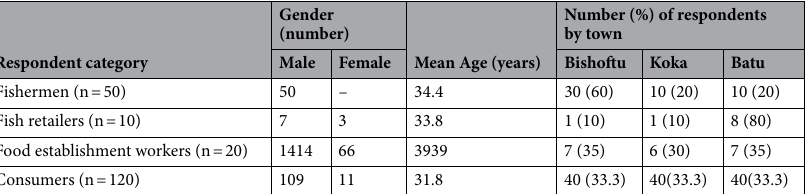
Table 1. Gender and age distribution of respondents along fish production and supply chain in three towns of east Shewa zone of Oromia, Ethiopia.